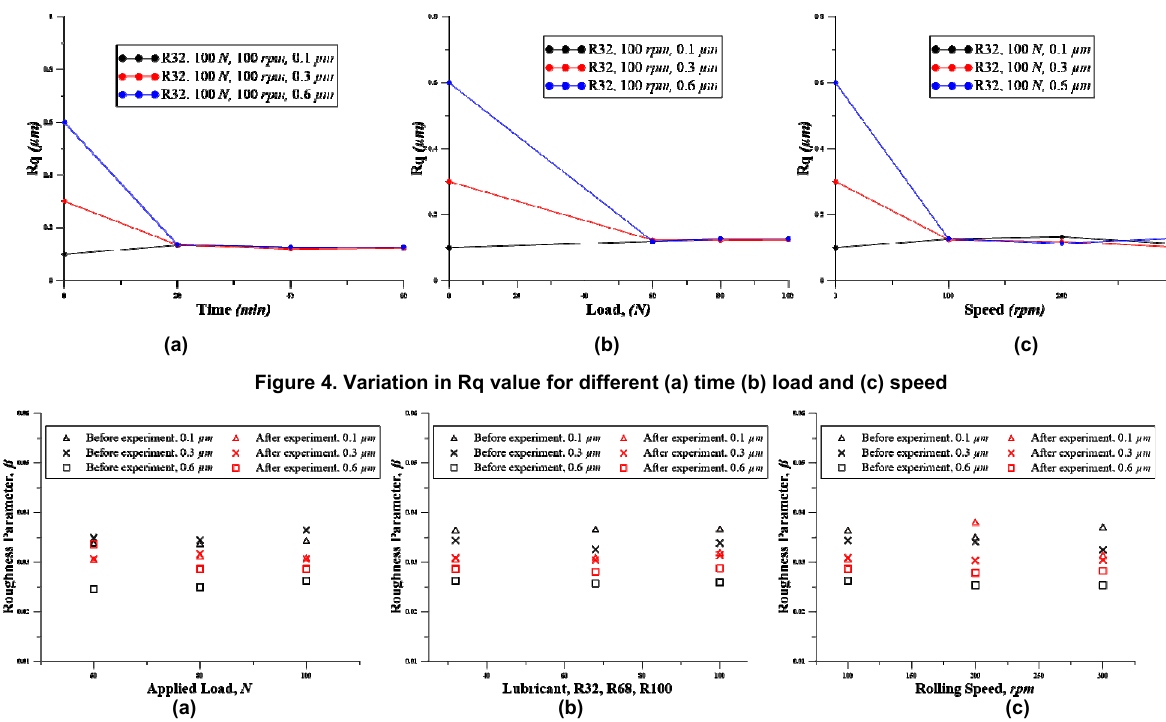
Figure 5. Variation in dimensionless surface roughness parameter for different (a) load (b) lubricant and (c) speed